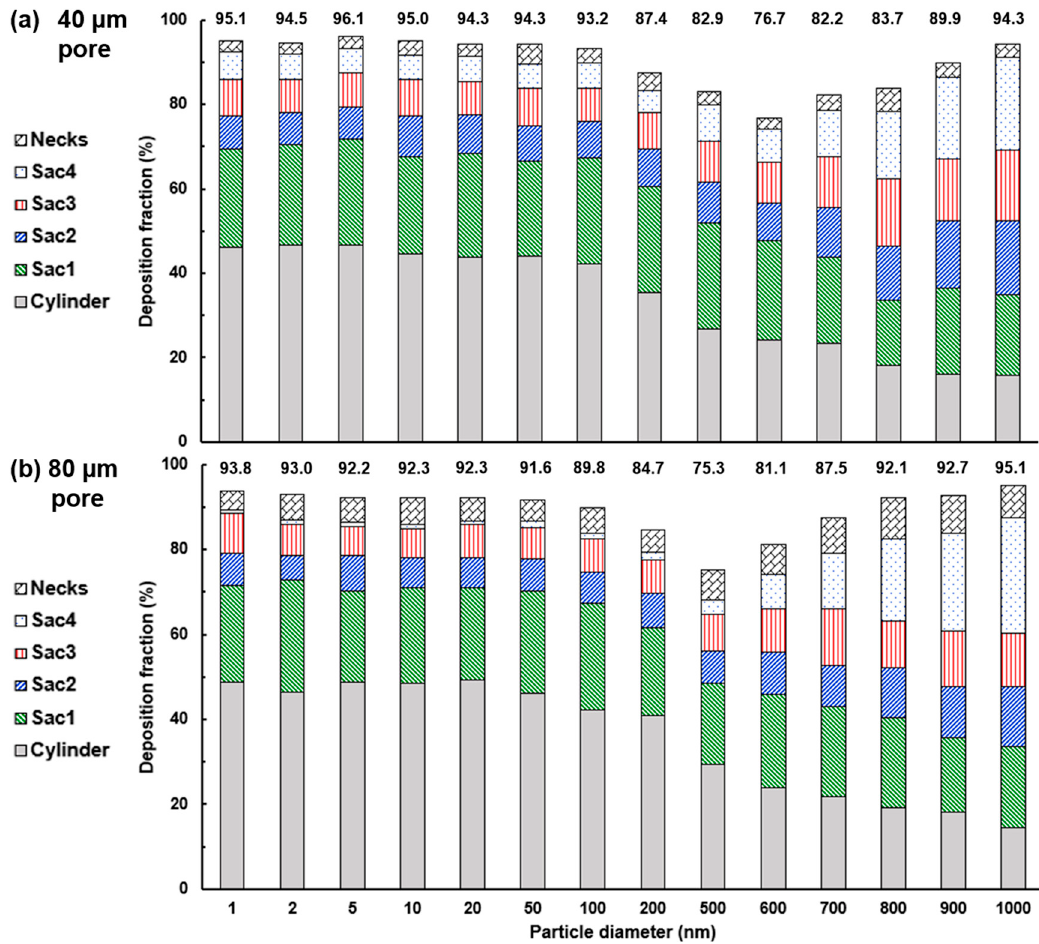
Figure 11. Of total and sub-regional deposition fractions as a function of particle diameter between ( a ) 40-nm-pore and ( b ) 80-nm-pore alveolar models.